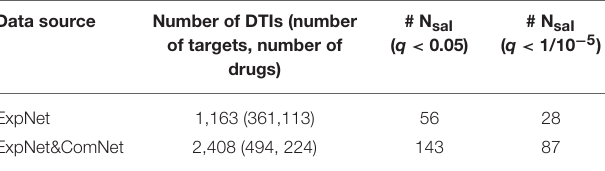
TABLE 2 | Summary of the newly predicted anti-aging indications of natural products based on the experimentally reported drug-target network only (ExpNet) and the combination of the experimentally reported and computationally predicted (ExpNet&ComNet) drug-target networks,